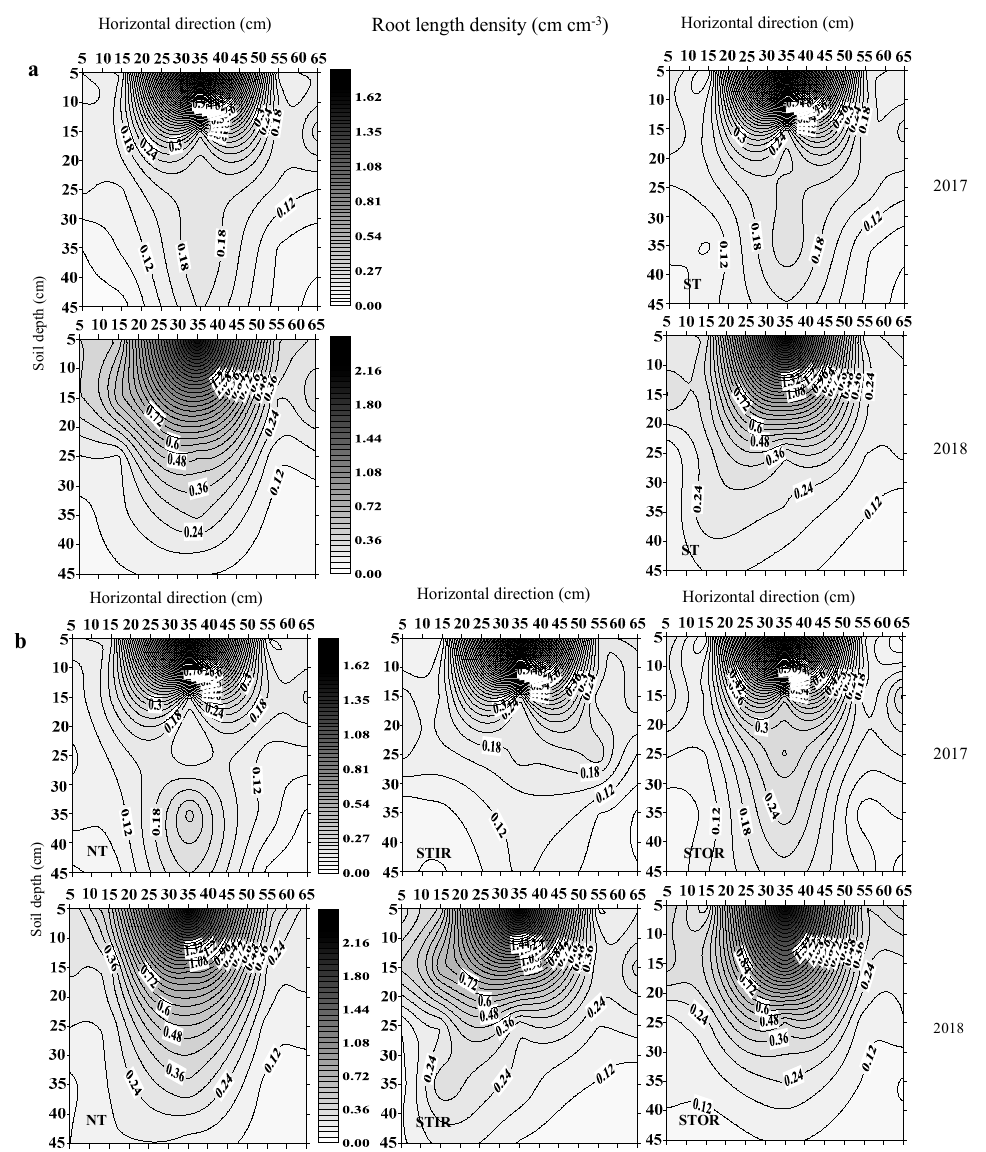
Figure 4. Effect of different tillage practices on root length density of maize at the flowering stage. ( a ) wheat season tillage; ( b ) maize season tillage. RT: rotary tillage; ST: subsoiling tillage; STIR: inter–row subsoiling tillage; STOR: on–row subsoiling tillage. For the vertical distribution of root surface area density, neither of the tillage prac-